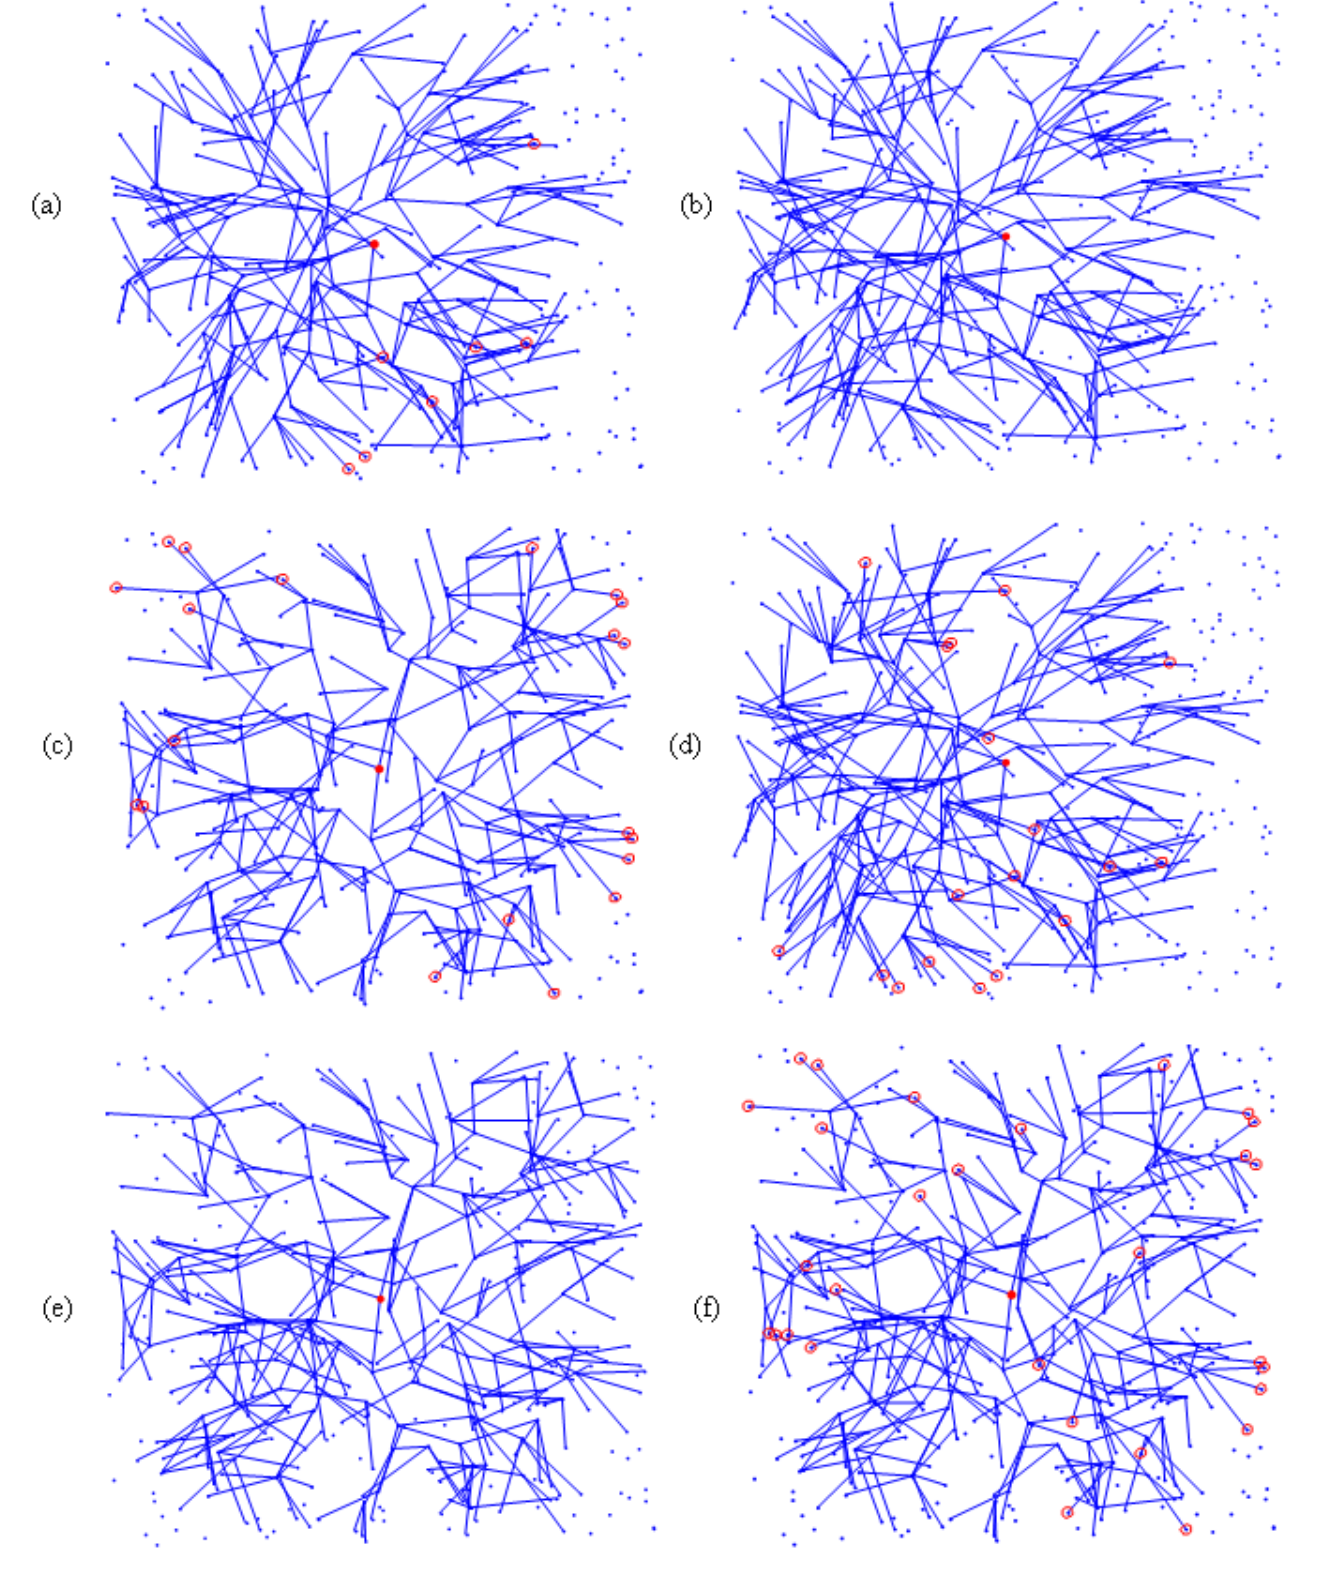
Figure 6. ZigBee and DBS associated routers networks for different